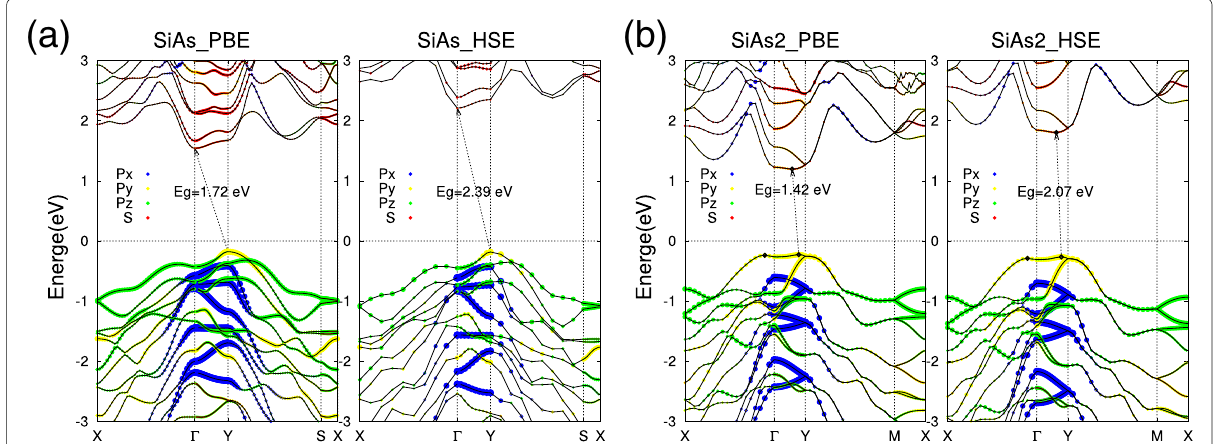
Fig. 3 Band structures of monolayer SiAs and SiAs 2 calculated by PBE and HSE06. The electronic orbital decomposition of band structures of monolayers SiAs and SiAs 2 are represented as a and b , respectively. The red dots denote s orbital, while blue, yellow, and green are p x , p y , and p z , respectively. The Fermi level is set as zero and indicated with a dot line